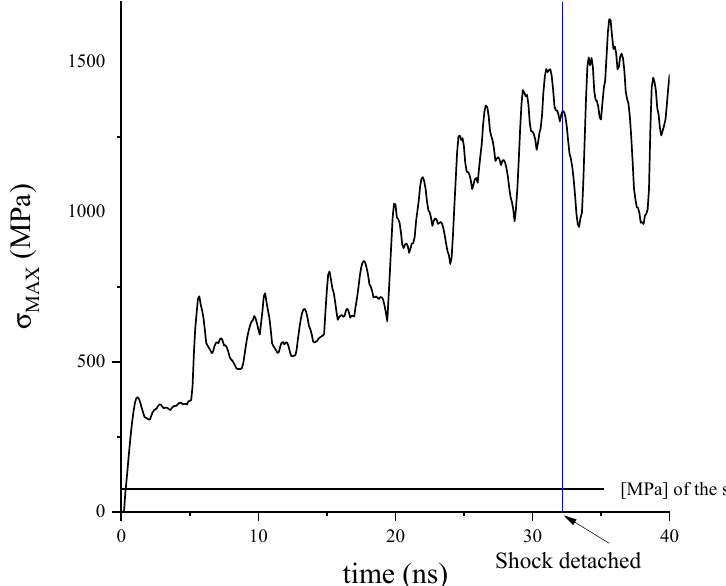
Figure 4. Variation of maximum equivalent stress in scale with time.